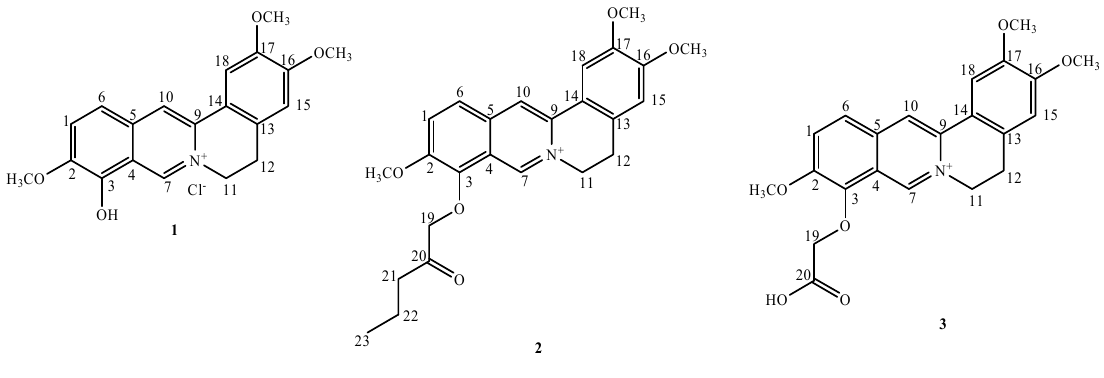
Figure 3. Structures of compounds ( 1 – 3 ).